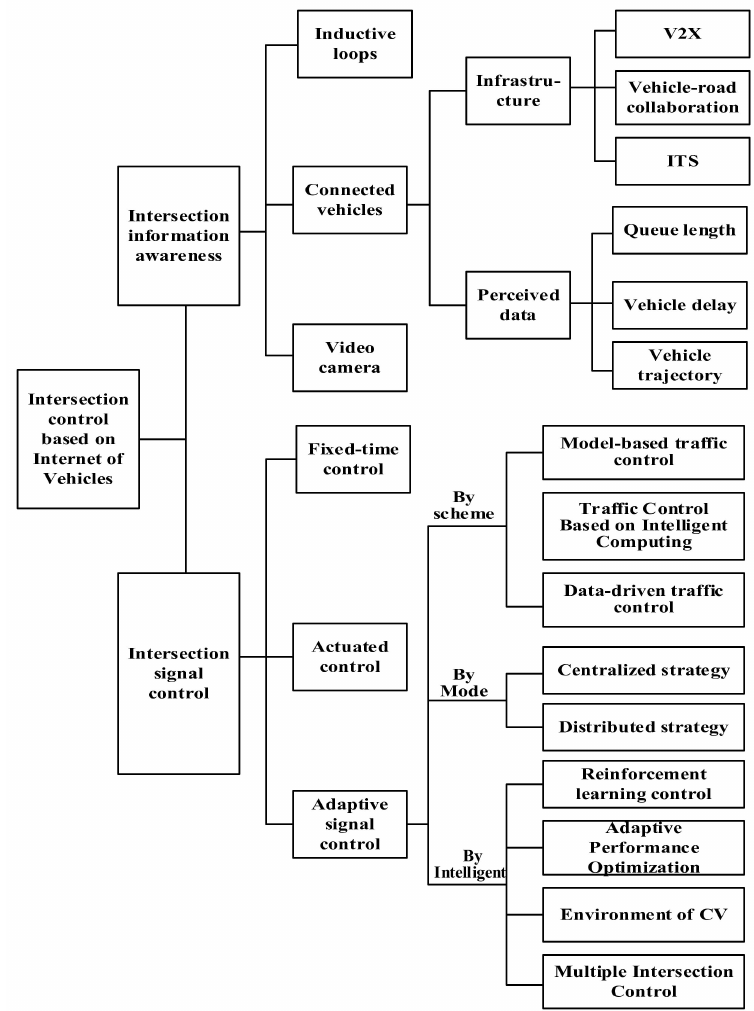
Figure 2. Overview of the related